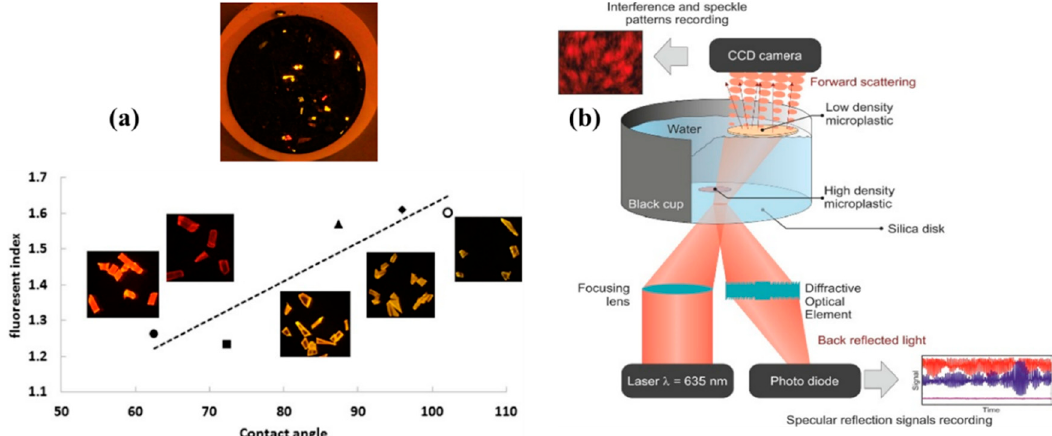
Figure 2. ( a ) Microplastics of six different polymer types dyed with Nile Red taken with a blue light (450 − 510 nm) and orange filter (529 nm) and their fluorescent index as a function of contact angle (reproduced from [21]); ( b ) schematic of a portable prototype optical sensor for detection of both transparent and translucent microplastics in water (reproduced with permission from [22]).